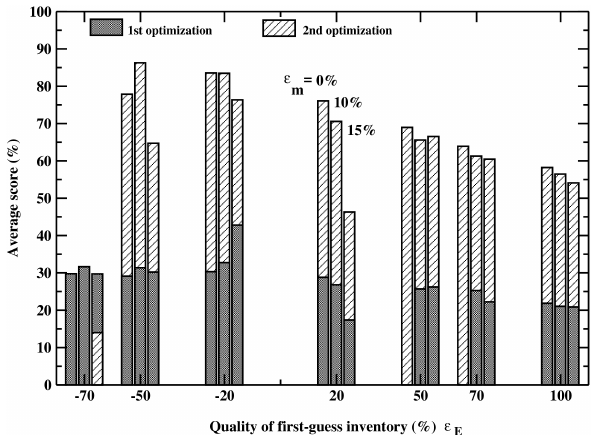
Fig. 10. Times series of ozone concentrations for the true inven- tory, the first-guess +100% inventory and the analysis obtained with (cid:15) m =15% for a cell located in the plume.